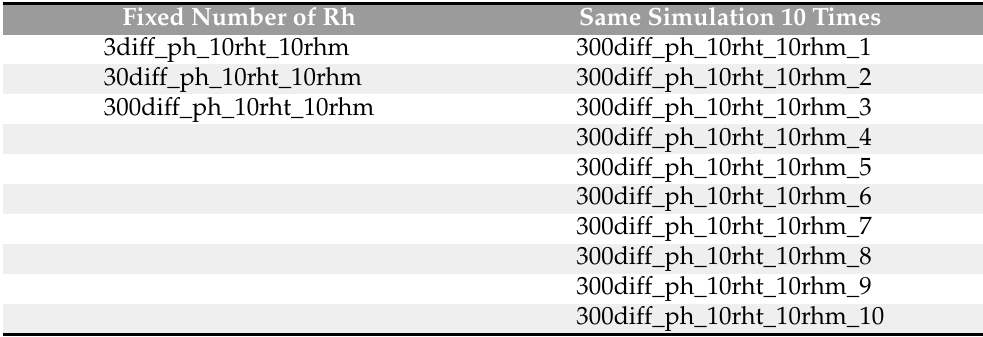
Table 2. Simulations in which Ph have multiple service types and different amounts. Fixed Number of